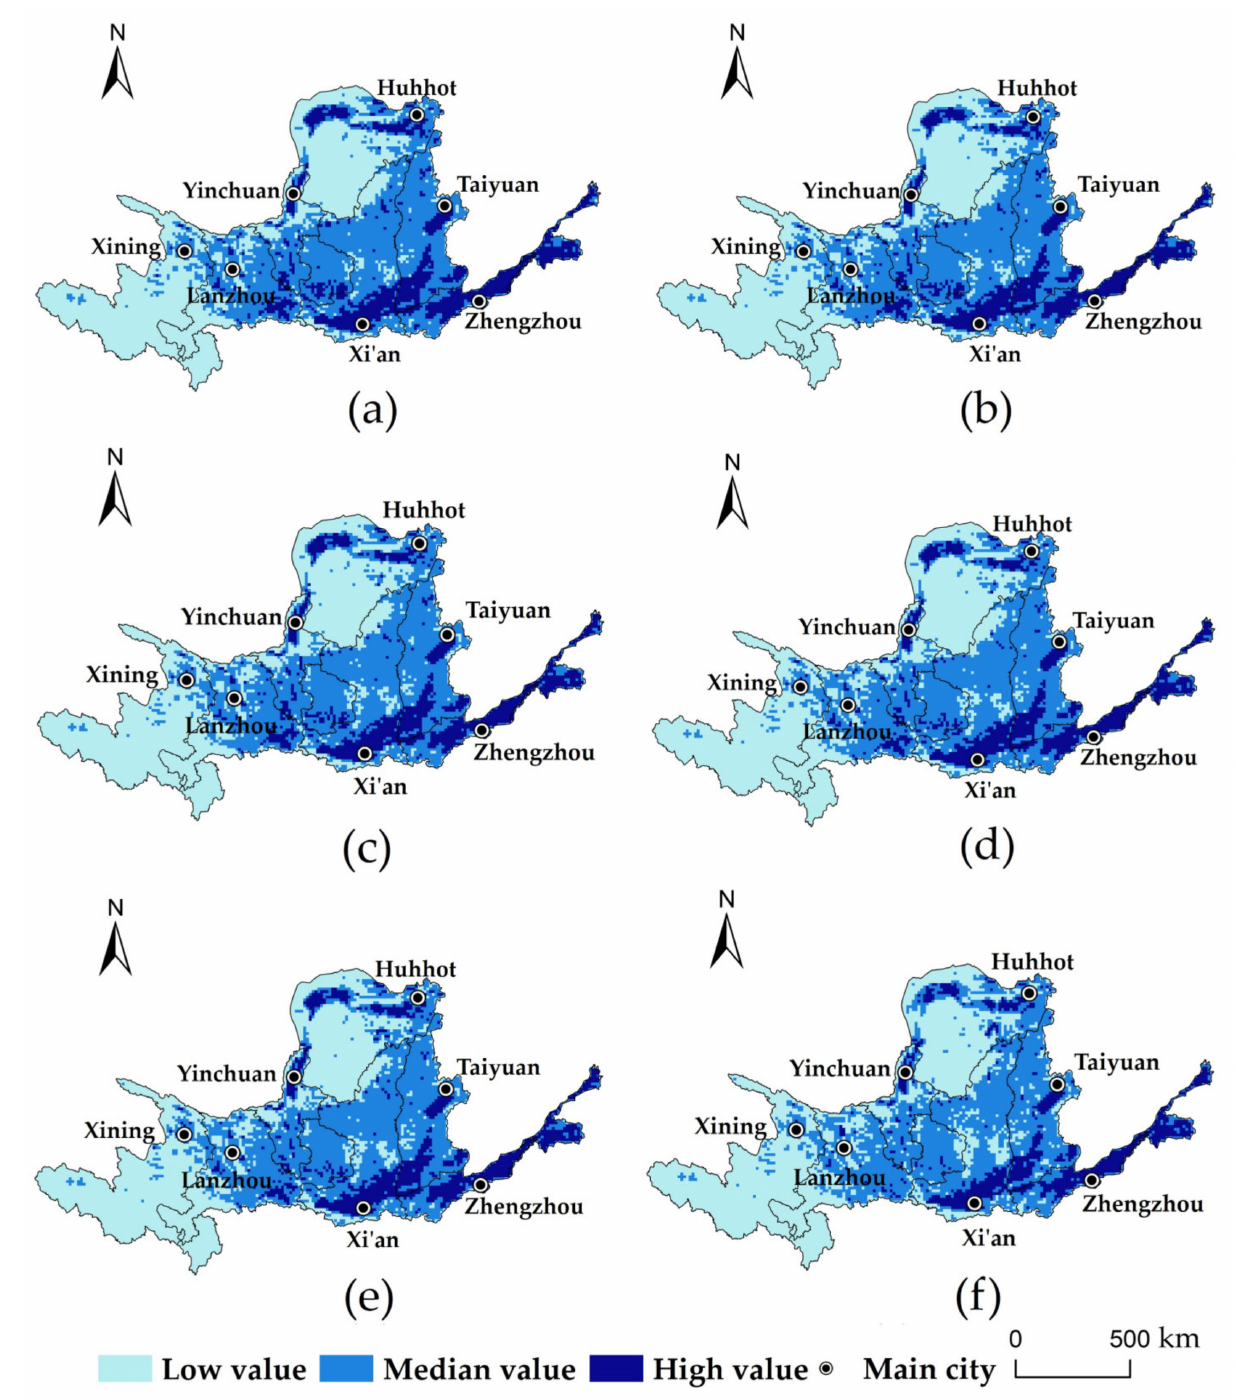
Figure 6. Spatial distribution of social benefits of land use in the Yellow River Basin: ( a ) 1995; ( b ) 2000; ( c ) 2005; ( d ) 2010; ( e ) 2015; ( f )